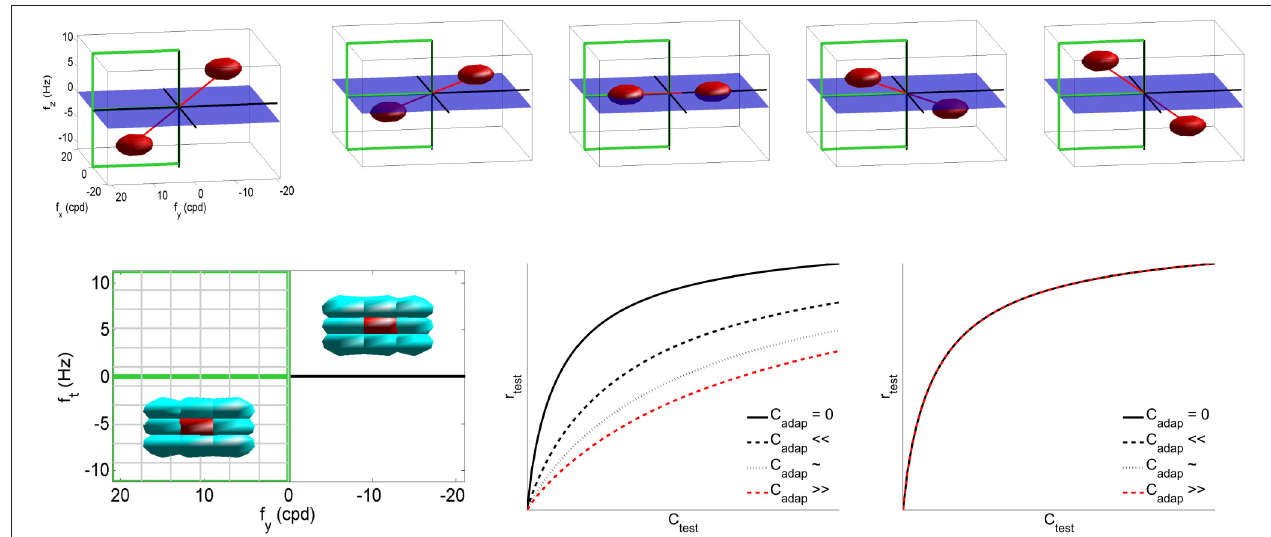
FIGURE 2 | The classical linear-nonlinear V1 model to describe the motion aftereffect. Code for the empirical model and the experiment in this section is available at http://isp.uv.es/after_effects/. Top row shows examples of the spatio-temporal frequency response of sensors in the linear part of the motion sensing model, L . As stated in the text, such filters tile the visible region of the spatio-temporal Fourier domain. Bottom left plot shows the neighbor/interaction sensors (in cyan) of a particular sensor (in red), determined by the extent of H ij in N . Given the symmetry of the Fourier domain, in the following we will focus on the response of the filters tuned to the frequencies shown in the semi-plane highlighted in green (positive and negative vertical speeds). The nonlinear plots display the response of the i -th nonlinear sensor as a function of the amplitude of the i -th linear response, for progressively higher neighbor activities C j in the case of a similar test and adaptor (center) or a very different test and adaptor